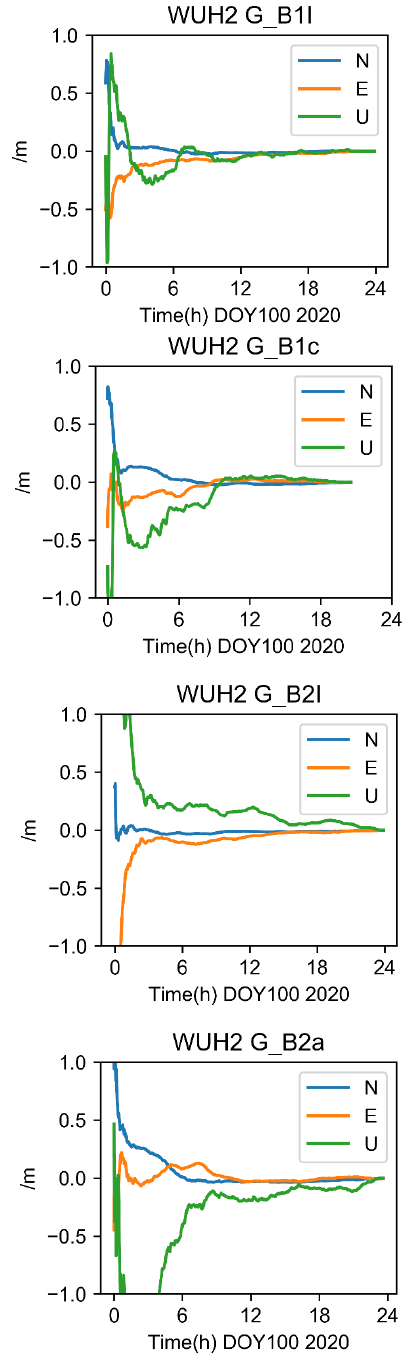
Figure 5. BDS B1I/B3I ionosphere-free results of WUH2.